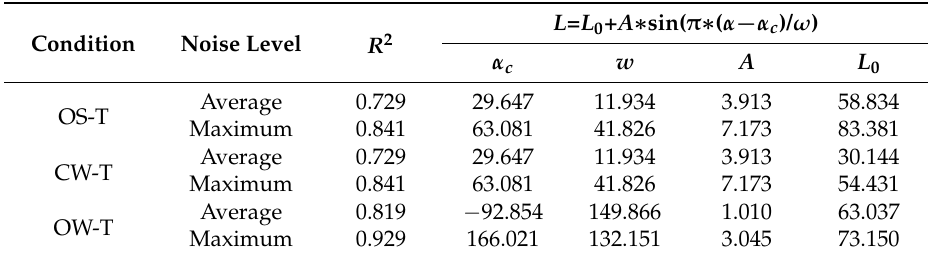
Table 6. Summary of Correlation modeling during aircraft take-off.